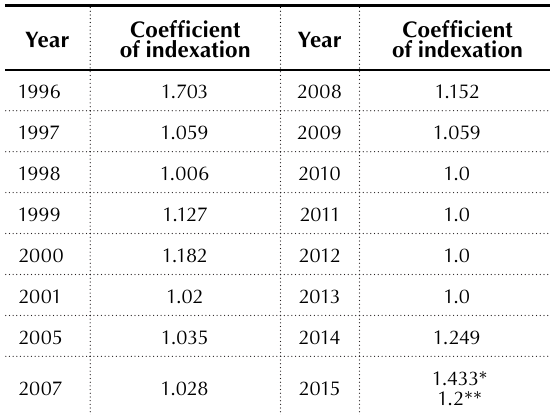
Table 3. Indexation coefficients of normative monetary valuation of land in